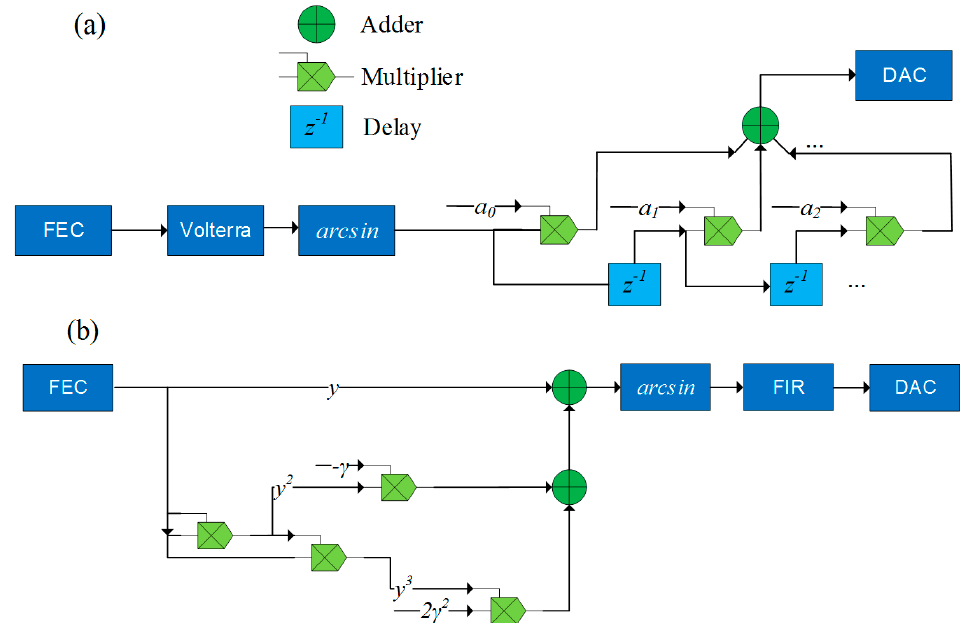
Figure 5. Proposed DSP block diagram. ( a ) The proposed structure of the FIR filter is shown in detail. a 0 , a 1 , a 2 , and the rest are the tap coefficients determined from α . ( b ) The proposed structure of the Volterra filter is shown in detail.